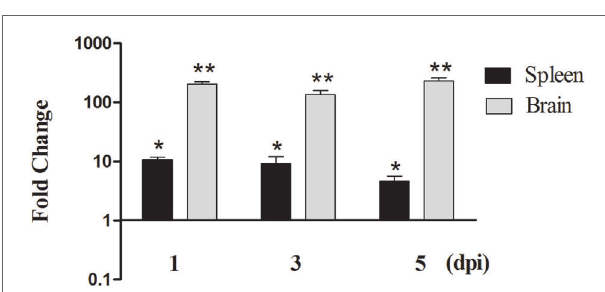
FigUre 3 | analysis of duMaVs transcript in ducks at early stages of DTMUV infection . The fold change was calculated by the experimental ducks versus control ducks at the same time point, using the 2 −ΔΔ Ct method. All data were expressed as means ± SD ( n = 5), and Student’s t test was performed to evaluate the differences. *Significant difference ( P < 0.05); **highly significant difference ( P < 0.01).